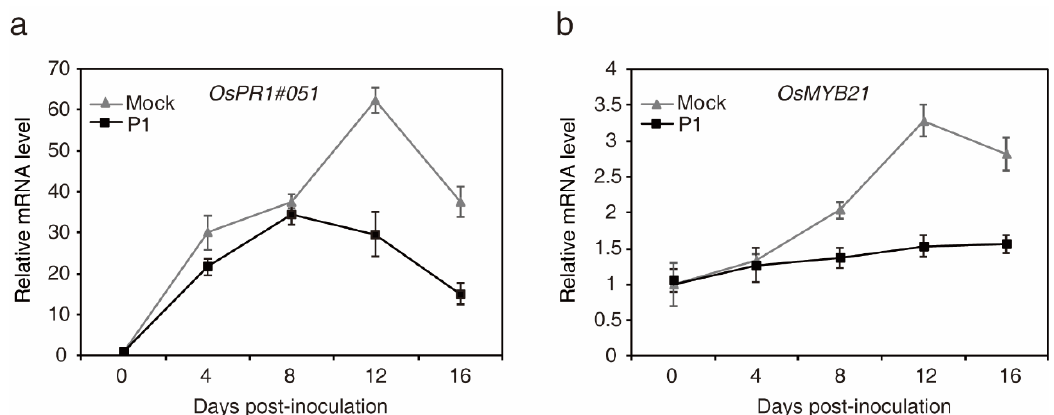
Figure 5. Expression analysis of defense- and heading date-related genes of rice cultivar LYP9 during U. virens infection. Total RNAs were prepared from rice spikelets collected at 0, 4, 8, 12 and 16